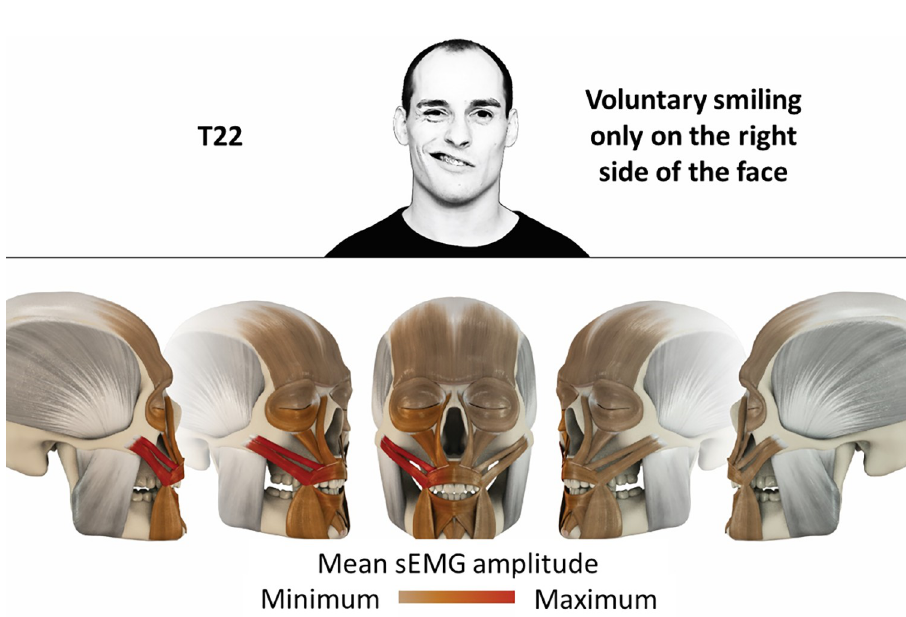
Fig 23. Color-coded facial muscle activation pattern of task T22. Voluntary smiling only on right side of the face. Animation by Jonas Laustro¨er.